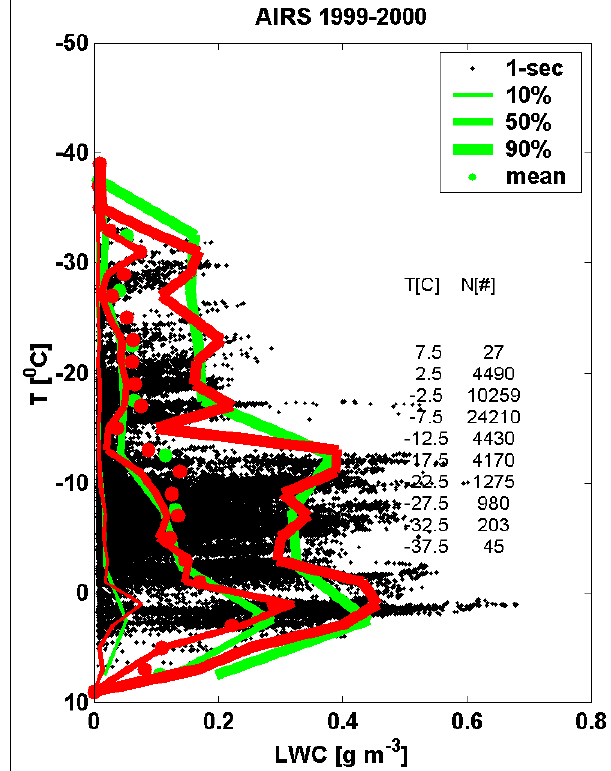
Fig. 7. Comparison of LWC values averaged over 5 ◦ C intervals (green lines) and 2 ◦ C intervals (red lines). The black dots are for observations from the AIRS field